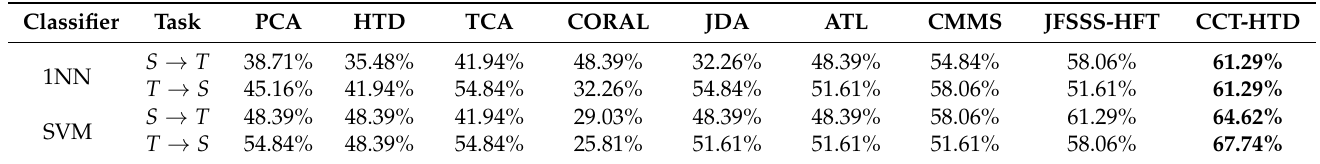
Table 7. Classification accuracies of different domain adaptation methods with 1NN and SVM using dataset